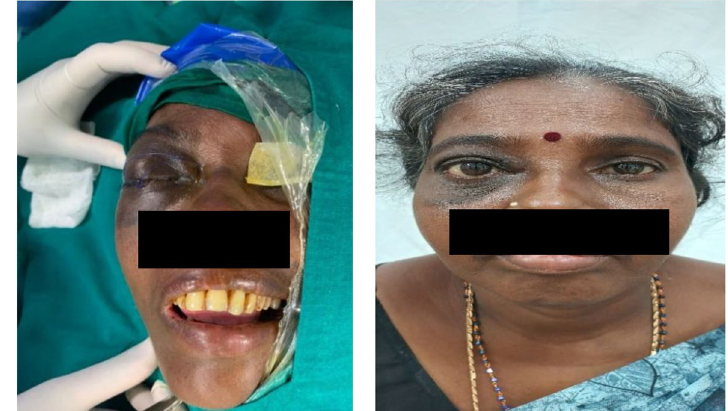
Fig. 3 Pre-op picture showing right eye proptosis and post-op